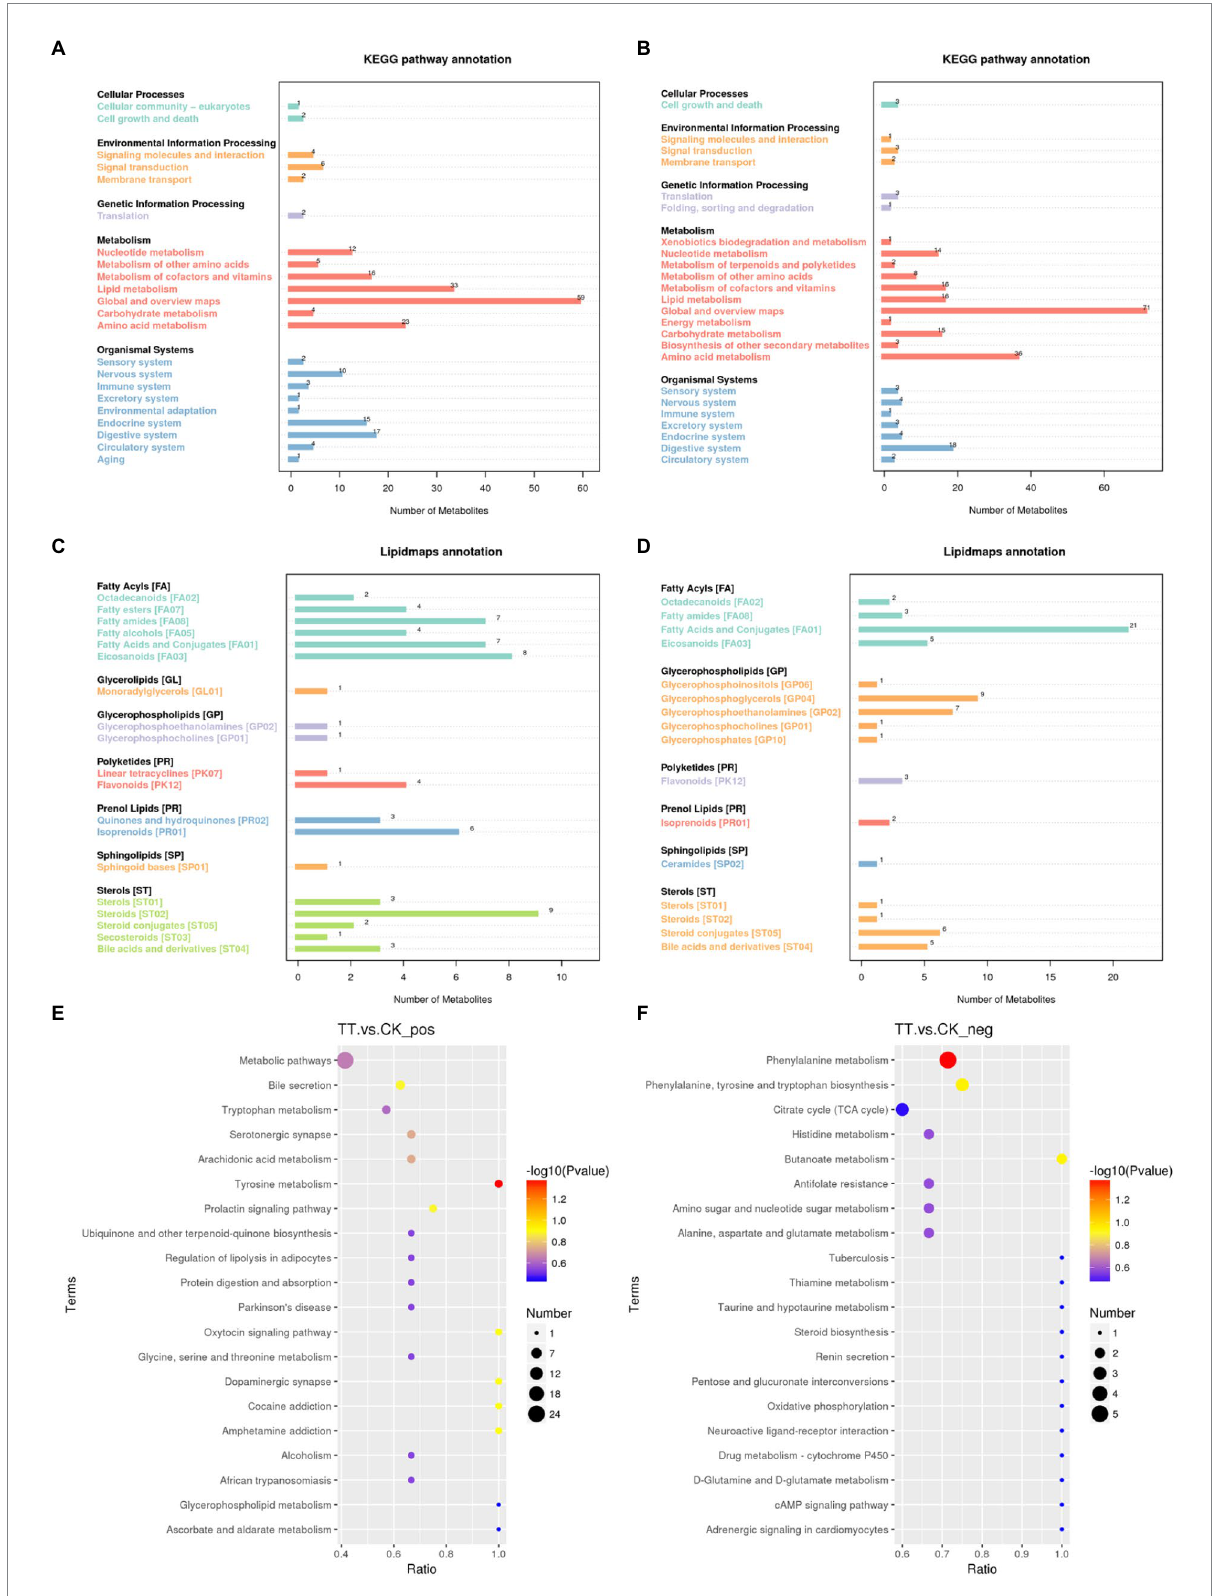
FIGURE 4 Metabolic pathways enriched in the cecum. (A,B) KEGG enrichment analysis. (C,D) LIPID MAPS enrichment analysis. (E) KEGG enrichment analysis in positive ion mode. (F) KEGG enrichment analysis in negative ion